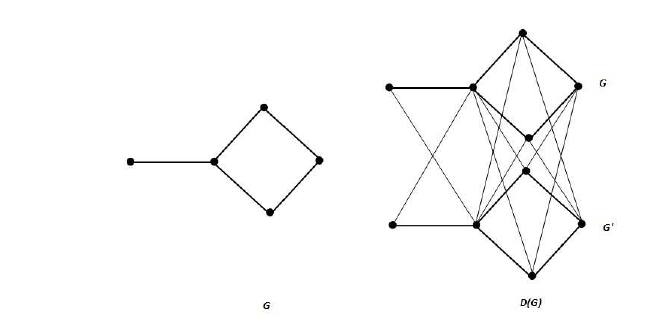
Fig. 1 A graph G and its double graph D [ G